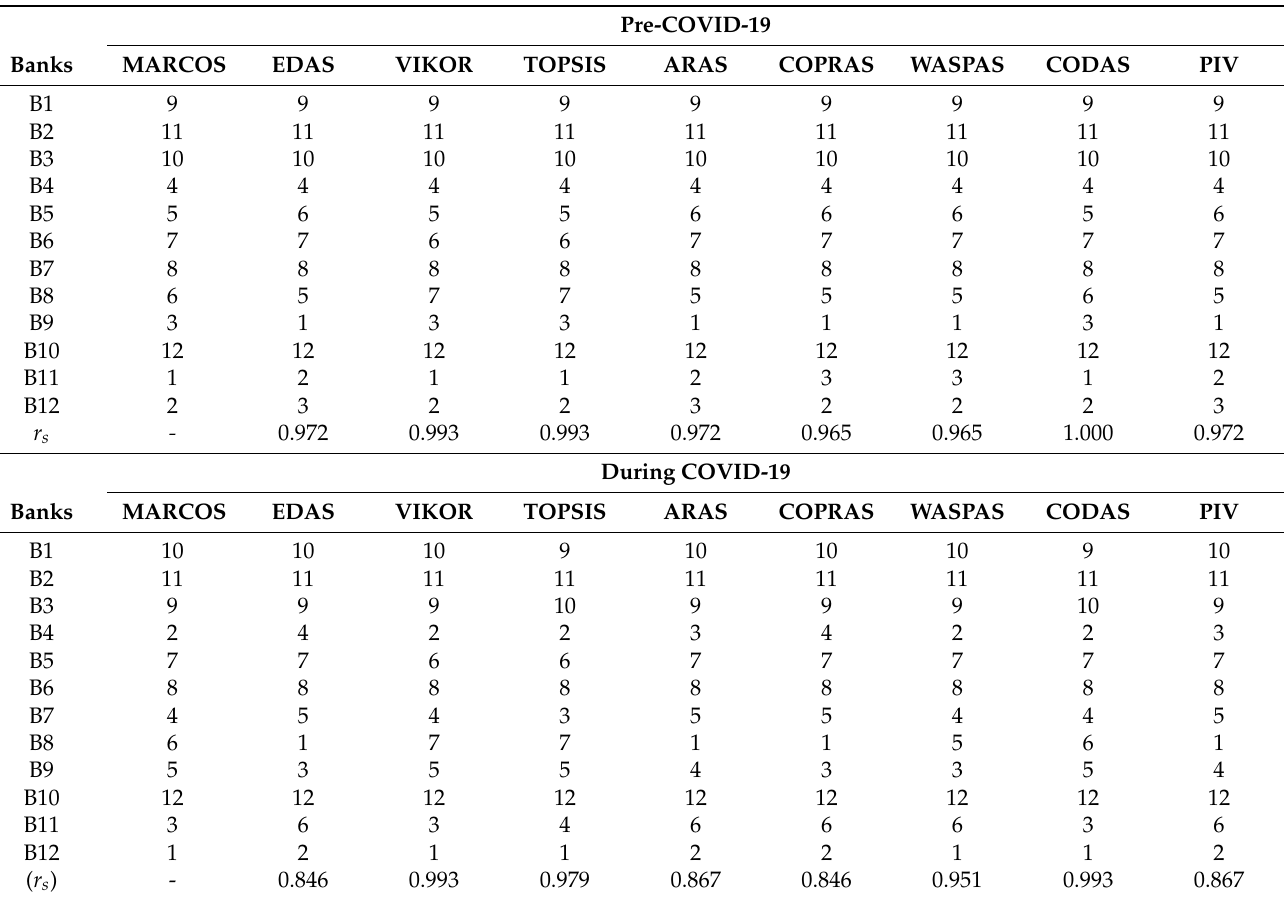
Table 18. Results of the comparative analysis for bank productivity pre- and during